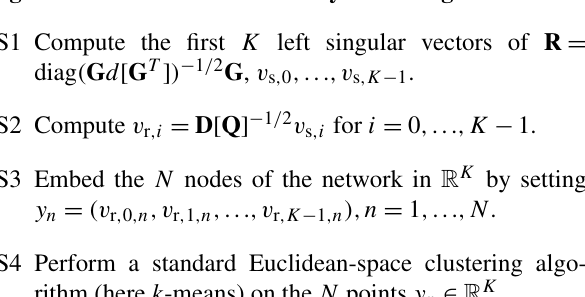
Algorithm 1: simultaneous K -way